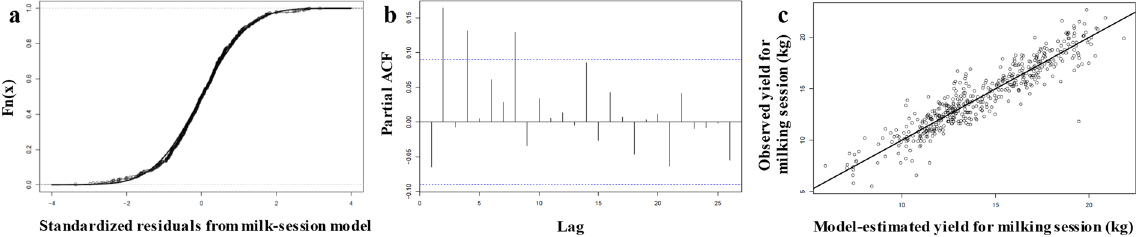
Figure 2. Validating the milking-session model. ( a ) Cumulative distribution of the model’s standardized residuals overlain by the normal cumulative distribution curve (KS test: P-value = 0.45). ( b ) Partial estimate of autocorrelation for the standardized residuals (Box-Pierce test: P-value = 0.16). ( c ) Plot of model-estimated versus observed yield for milking sessions (best-fit line in black; r = 0.93).